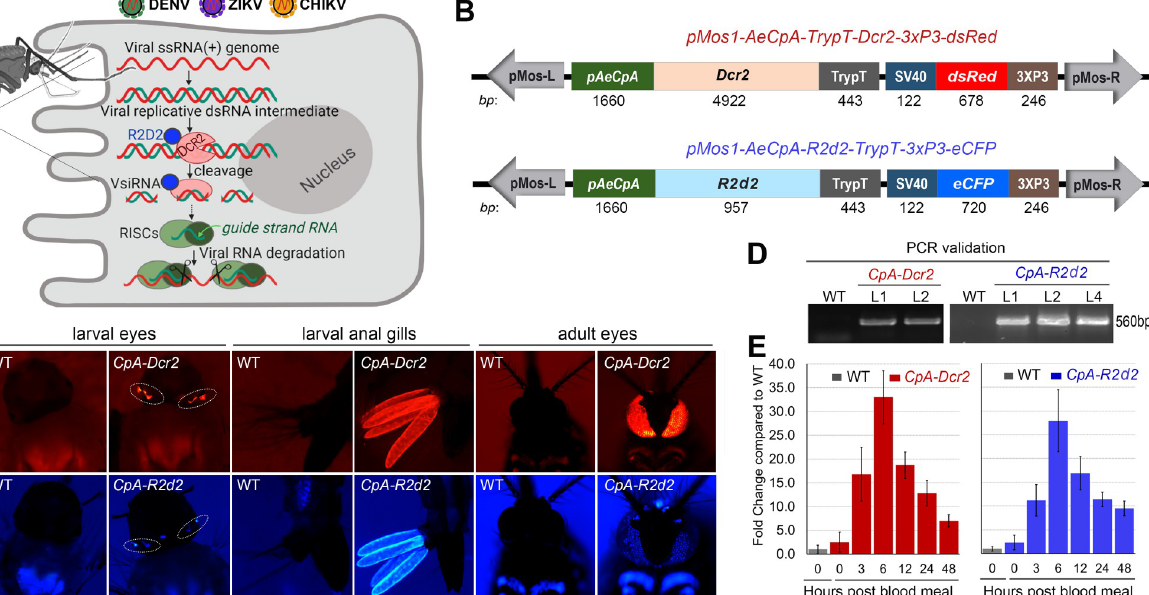
PLOS Biology | https://doi.org/10.1371/journal.pbio.3001668 June 9,